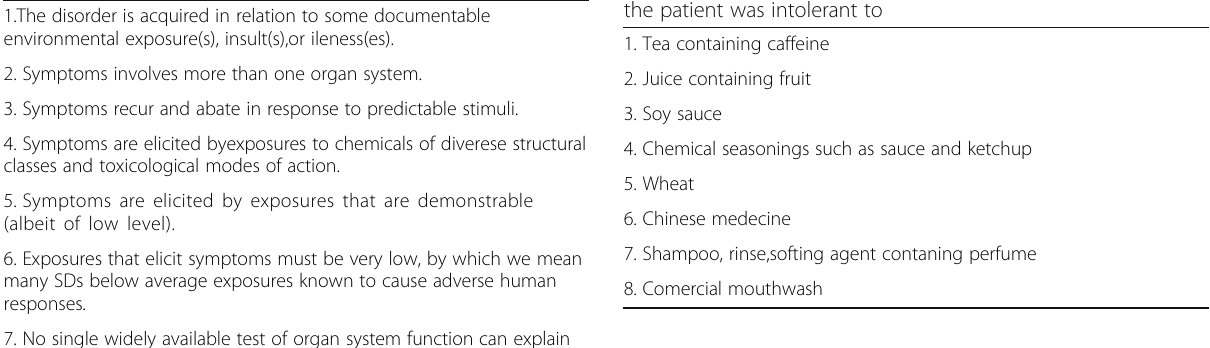
Table 1 Seven major diagnostic features of the MCS by Cullen